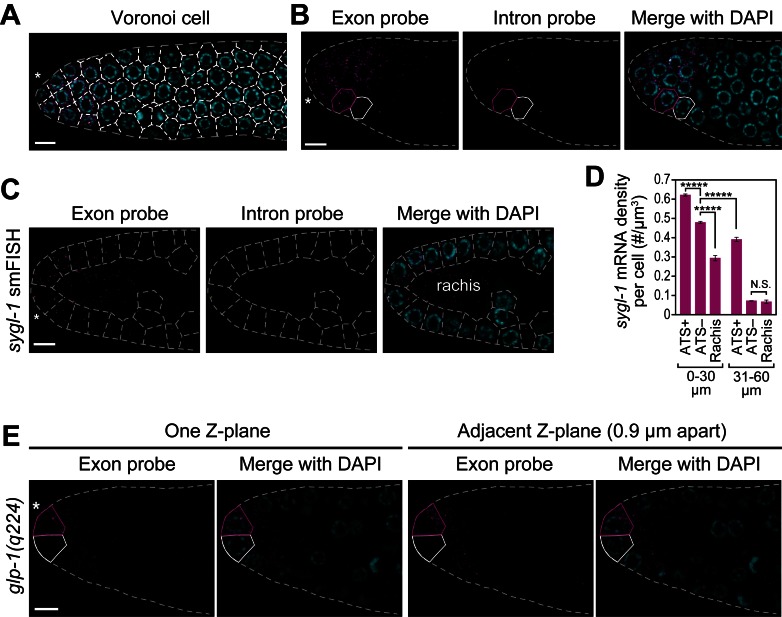
Cells with abundant sygl-1 mRNA can reside next to cells with little mRNA.(A,C) Germ cells are interconnected via cytoplasmic bridges to a central cytoplasmic core or ‘rachis’ that extends the length of the gonad (Hirsh et al., 1976). Germ cell boundaries (dashed lines) were determined using a 3-D Voronoi diagram (Ledoux, 2007; Yan et al., 2010) in MATLAB. A representative section of germ cell boundaries (Voronoi cells) in one Z-plane is shown. DAPI marks nuclei (blue). Conventions and scales as in Figure 1E. (B,E) Germ cells with abundant sygl-1 mRNA (magenta outline) can reside next to a neighbor with very little sygl-1 mRNA (white outline) in wild-type (B) or glp-1(q224) (E) adult gonad. Conventions and scale as in Figure 1E. One Z-plane is shown. (D) sygl-1 mRNA density (total number of mRNAs in cell or region divided by total cytoplasmic volume in same cell or region). Cytoplasmic volume excludes nuclear volume; volume in rachis was calculated from non-cellular germline tissue in region spanning 0–20 µm (4–5 gcd). *****p<0.00001; n.s.: not significant by t-test.